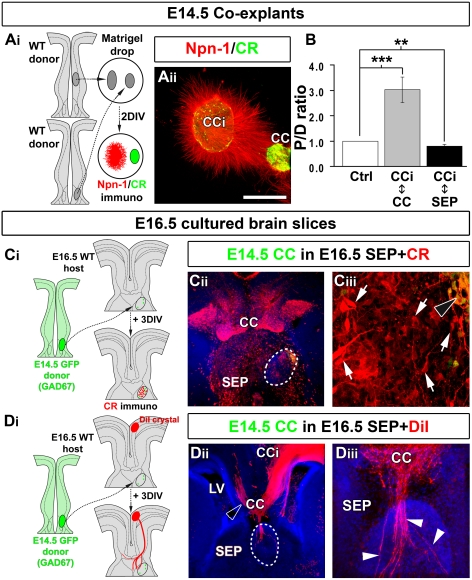
CC region enriched in glutamatergic CR-positive neurons attracts callosal axons.(Ai) Experimental paradigm used to determine whether the glutamatergic CR-positive neurons of the CC exert attractive effects on cortical axons. (Aii) Immunohistochemical staining for CR/Npn-1 on coexplants of E14.5 cingulate cortex (CCi) cocultured with E14.5 CC. (B) Quantification of the axonal guidance responses to E14.5 CC and septum (SEP) explants. Data are expressed as a P/D ratio, where P and D are the mean fluorescence intensity ±SEM in the quadrants proximal and distal to the CC or SEP explants. Double asterisks (**) indicate significantly different with p<0.01; triple asterisks (***) significantly different with p<0.001. Glutamatergic CR-positive neurons of the CC cause strong chemoattraction on cingulate axons, whereas the SEP is repulsive. (Ci–Ciii) CR immunostaining showing that E14.5 CC midline explants obtained from GAD67-GFP transgenic mice are highly enriched in CR-positive glutamatergic neurons (arrows) compared to GAD67-GFP+ GABAergic interneurons (black arrowhead). (Di) Experimental paradigm used to determine whether the CC glutamatergic neurons exert attractive effects on callosal axons. To test this hypothesis, a small explant of E14.5 CC containing glutamatergic neurons but no GAD67-GFP–positive GABAergic interneurons is transplanted in the nonpermissive septal region. (Dii–Diii) DiI staining showing that numerous callosal axons penetrate the SEP through the CC explant containing only CR-positive glutamatergic neurons. Open arrowhead in (Dii) highlights callosal axons crossing the midline of the CC, whereas arrowheads in (Diii) indicate callosal axons that are misrouted within the SEP through the explant. Dashed lines outline the transplant localizations. Brain slices in (Cii, Dii, and Diii) were counterstained with Hoechst. Bar indicate 485 µm in (Cii and Dii), 435 µm in (Aii), 120 µm in (Diii), and 70 µm in (Ciii). LV, lateral ventricle.